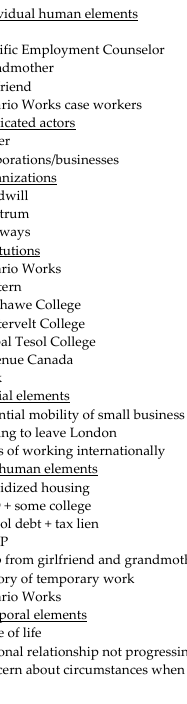
Figure 4. Ordered situational map—Tate.